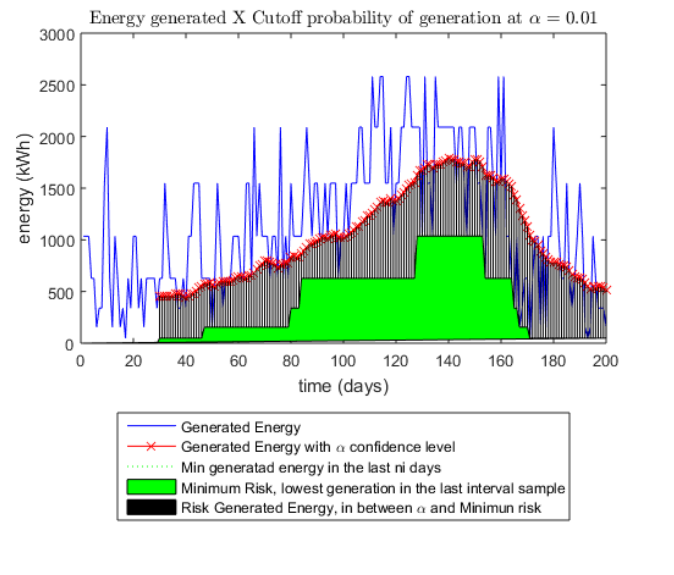
Figure 5. One year Wind Behavior—real generation and the generation